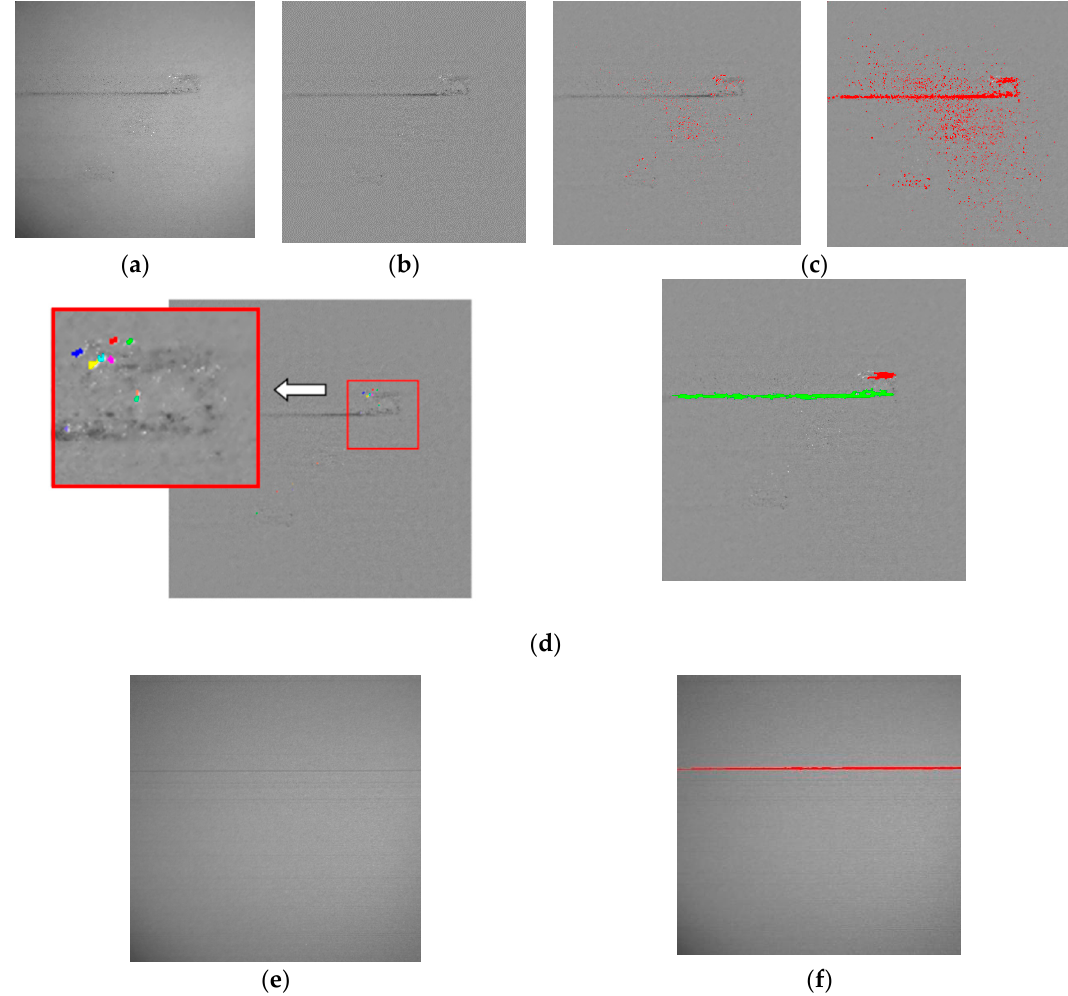
Figure 6. The defect extraction effect: ( a ) Original image. ( b ) Step 1. ( c ) Step 2: The image on the left is high threshold, and the image on the right is low threshold. ( d ) Step 3: The image on the left is cladding defect, and the image on the right is stripe defect. ( e ) Original image. ( f ) The extraction results.